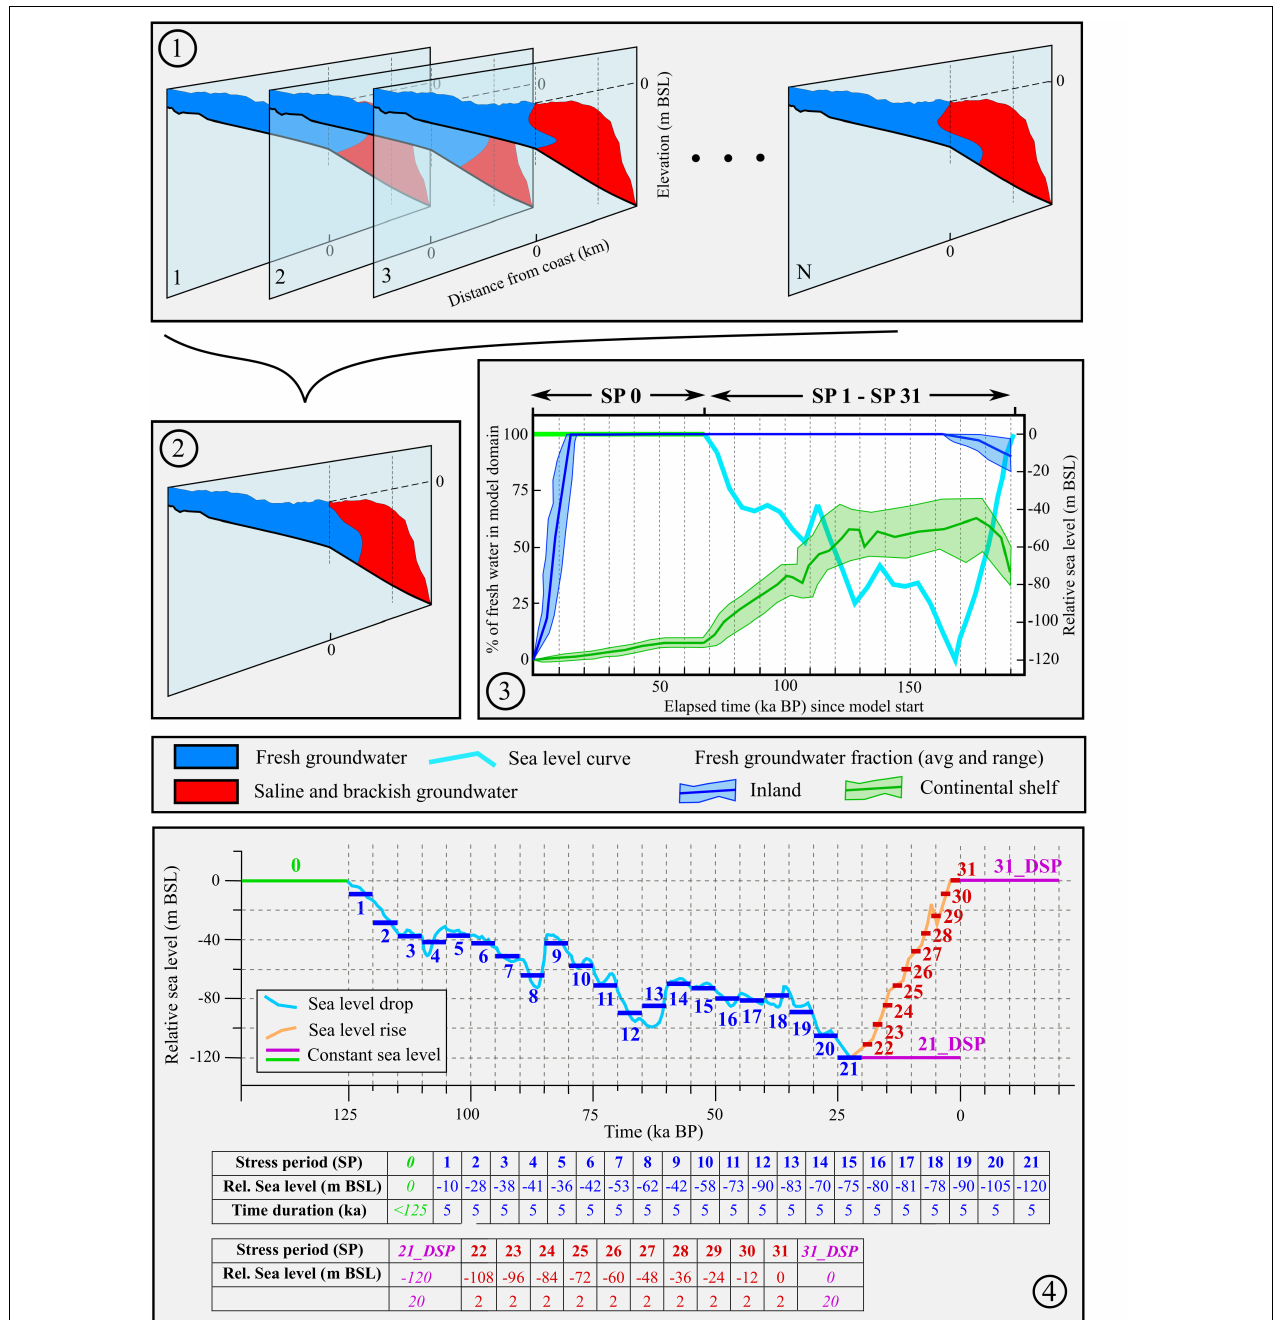
FIGURE 6 | Combining all SEAWAT models per COSCAT region into an average presentation: (1) a number of N generated SEAWAT models (with different synthetic heterogenic CUGS and other model input parameters, see Table 2 ), each with a different groundwater salinity distribution. The fresh groundwater fractions (FGFs) are measure in both the inland (first 10 km inland from the present coastline) and the continental shelf (stretch from present coastline to continental shelf edge) areas; (2) all model outputs at all time steps are then averaged into an aggregated average profile; (3) graph showing the average fresh groundwater fraction and the range of fresh groundwater fraction across all individual SEAWAT models (overall minimum and maximum value) through time with varying sea levels that are shown in (4) stress periods (SP) with corresponding sea levels (m BSL) relative to current situation and their time duration in thousands of years. In the graph, the sea levels as a function of the past 125 ka (light blue and orange lines) are derived from Grant et al. (2012). The upper table shows stress periods with generally decreasing sea-level trend (blue horizontal segments in the graph) while the lower table corresponds to a time period of comparatively fast sea-level rise during the past 20 ka (red horizontal segments in the graph). So-called dynamic SPs (DSPs) are also implemented to study the groundwater systems dynamics in the selected COSCAT regions. Green line is implemented in the SEAWAT models to simulate the initial salinity profile (saline initial condition only) and is set to last no more than 125 ka (equal to one full glacial cycle); 21_DSP (20-0 ka BP) is set up to investigate the system inertia at the absolute sea-level low stand, while in 31_DSP (0–20 ka), we investigate the system inertia and in the future 20 ka with sea level kept at current level (0 m BSL).